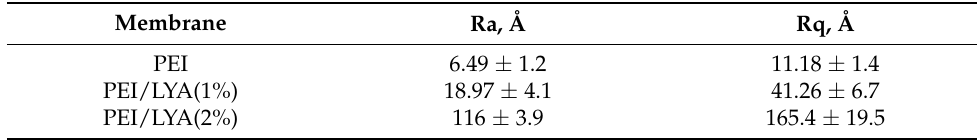
Figure 8. AFM images of the ( a , b ) PEI and ( c – f ) PEI/LYA membranes. Table 3. The surface roughness of the membranes.